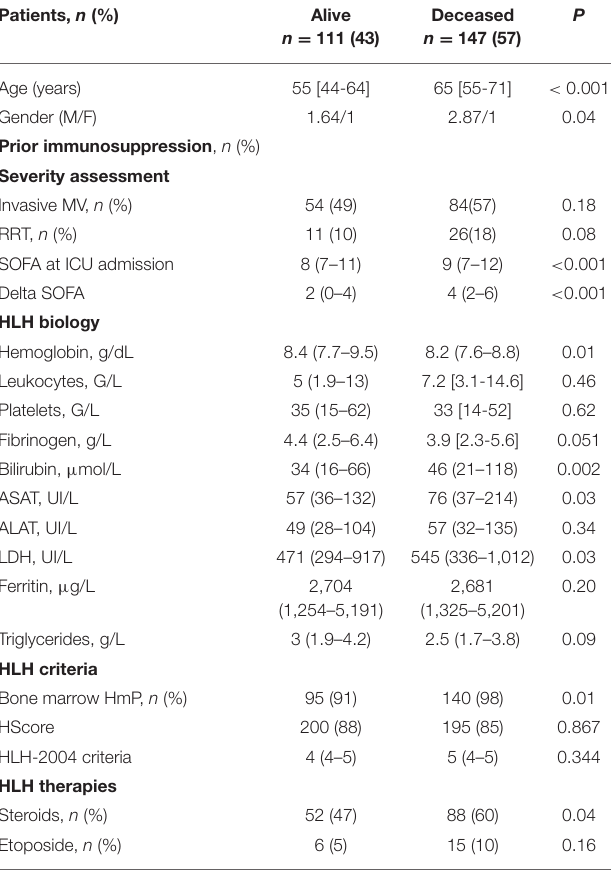
TABLE 3 | Differences between HLH patients according ICU mortality- univariate analysis. Patients, n (%)